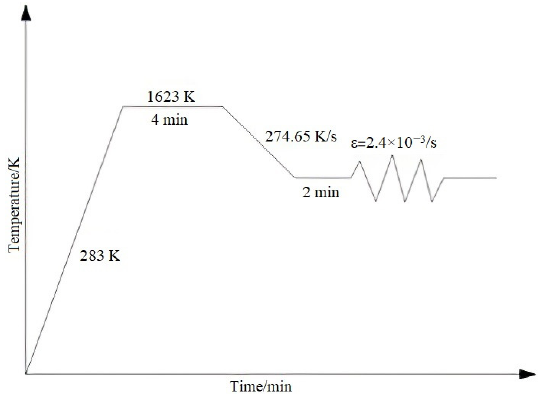
Figure 2. High ‐ temperature stretching heating system.